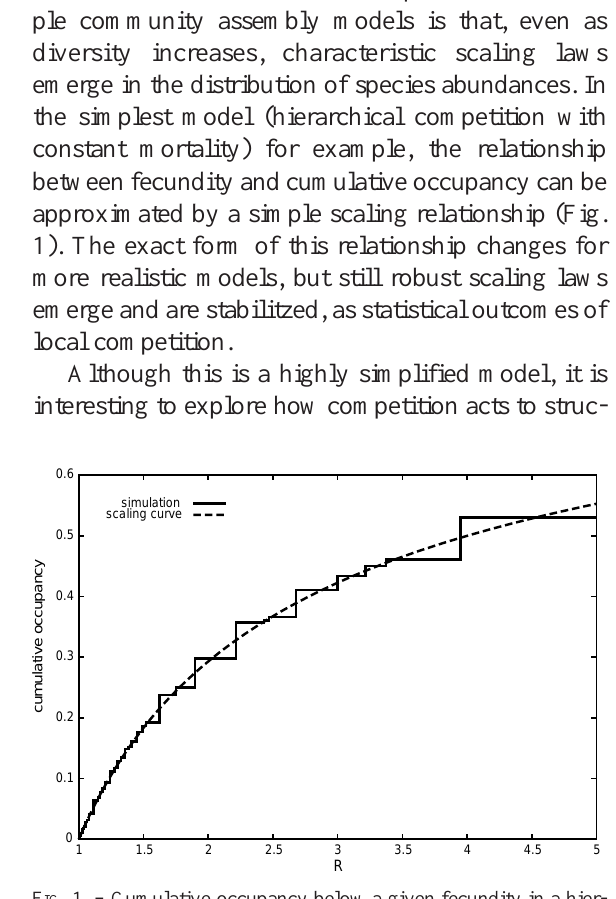
F IG . 1. – Cumulative occupancy below a given fecundity in a hier- archical model (with constant mortality), plotted together with the scaling relation 1 – [1/( R )] 1/2 , where R = f / m . This community was assembled using 1000 species chosen with R = 10 U , where U is a uniform random variate, and added sequentially (with inviable species allowed to go extinct after each introduction). The observed pattern (the vertical spike for each species intersecting the scaling curve) is the same for any assemblage of